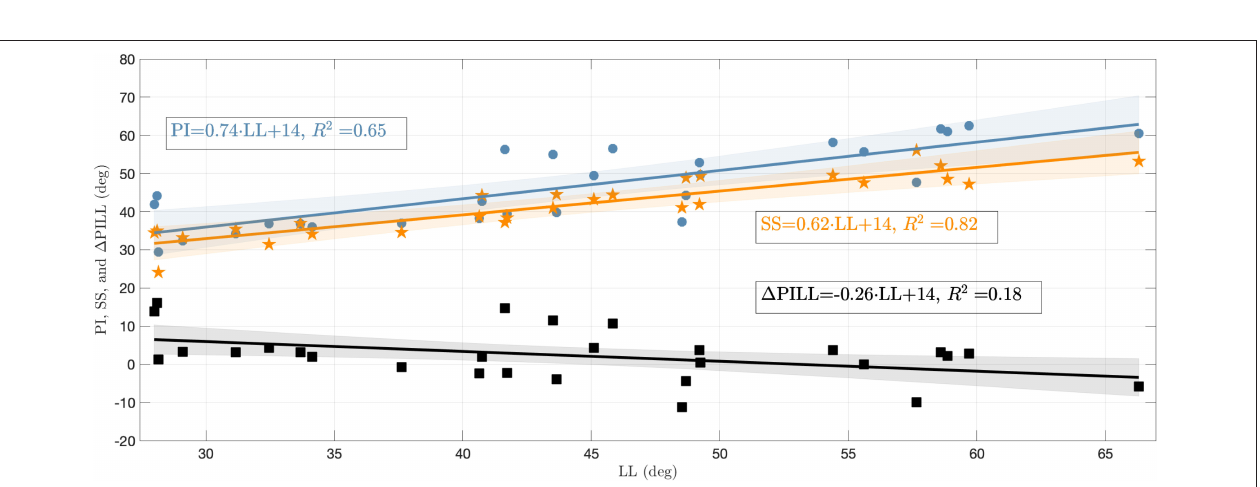
FIGURE 2 | Examples of lumbar spinal curvature: (A) hypolordotic (LL the LL, the sacral slope (SS), and the pelvic incident (PI) is sketched in (D) and described in the text. A vertical force of 500N (blue arrows with dashed line of action) was applied on the COM of the vertebral body of L1 in all models.